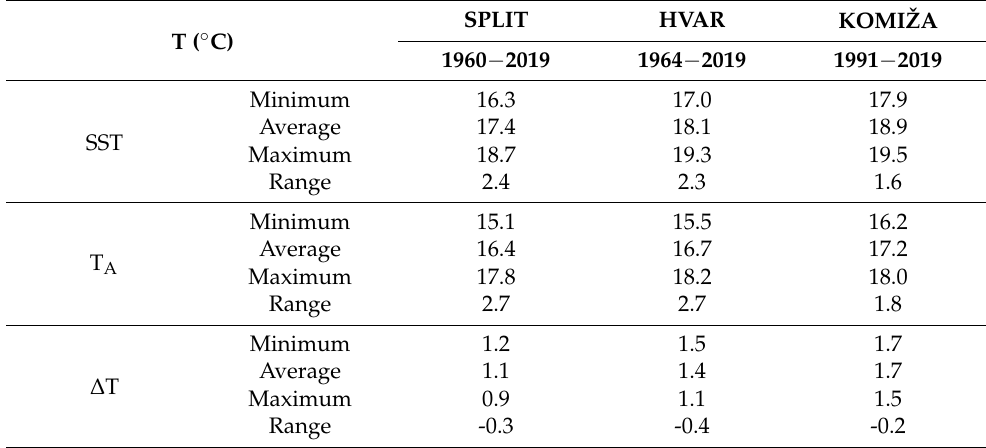
Table 2. Statistics (minimum, average, maximum) of the mean annual SST, air temperature (T A ), and their difference ( ∆ T = SST-T A ). SPLIT HVAR T ( ◦ C)